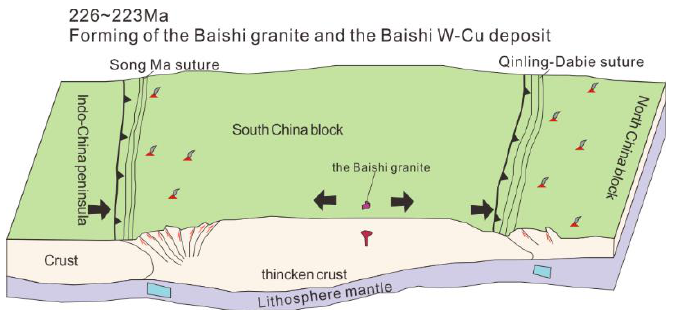
Figure 8. Geodynamic model for the forming of Baishi granite and the Baishi W-Cu deposit.